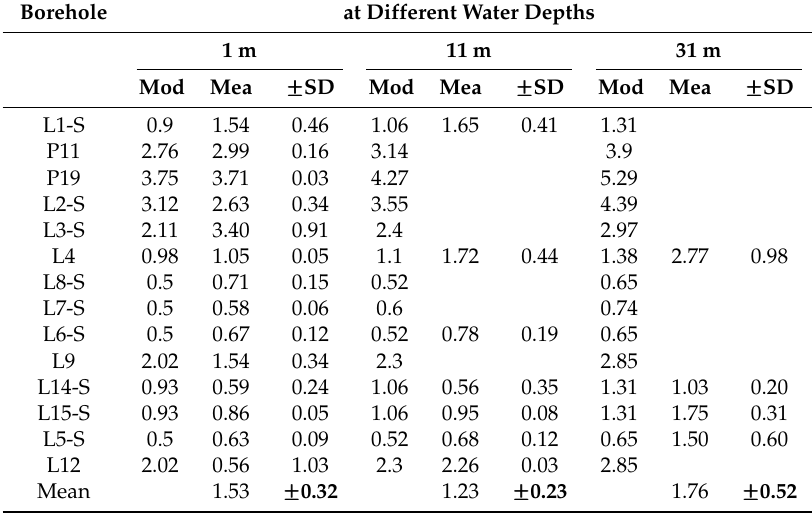
Table 2. Comparison between modelled (Mod) values of groundwater salinity ( i.e. , Rockwork15 input data at t = 0) and measurements (Mea) at three water depths into boreholes of the Bari aquifer. SD stands for the standard deviation between measured and modelled